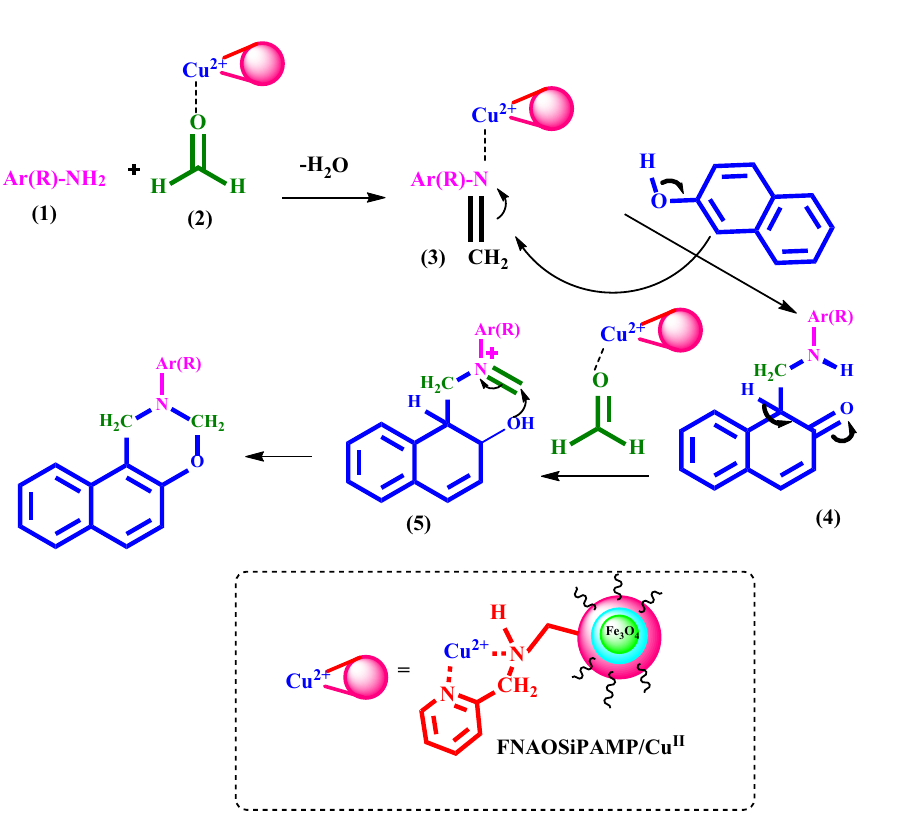
Figure 11. Proposed mechanism for the synthesis of naphtho[1,2- e